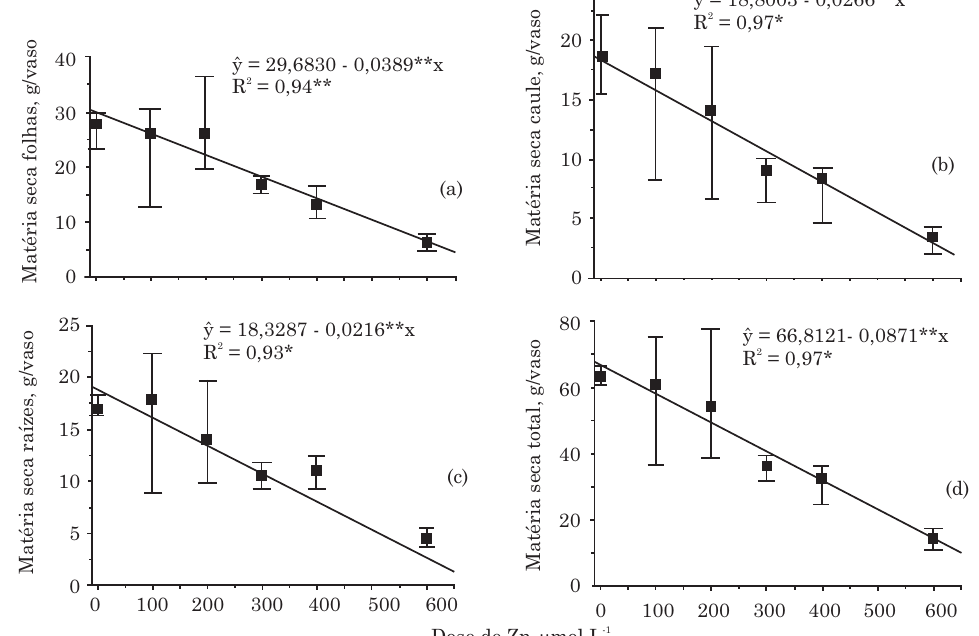
Figura 1. Matéria seca de folhas (a), caule (b), raízes (c) e total (d) de plantas de mamona cultivadas em doses de Zn em solução nutritiva. * e **: significativo a 5 e 1 %,